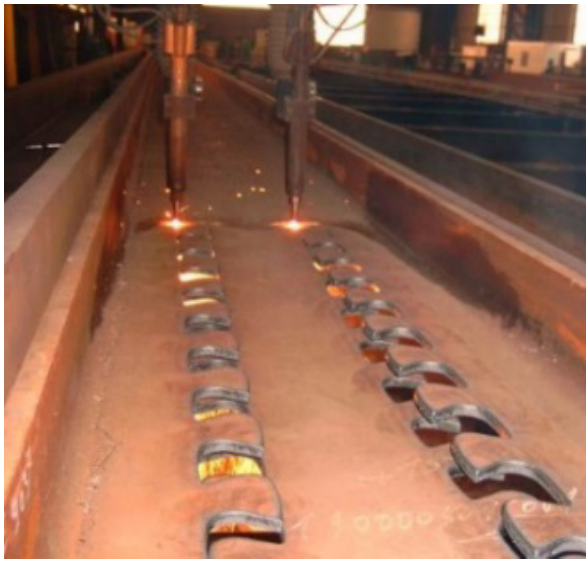
Figure 9: Fin-shaped dowel [30].